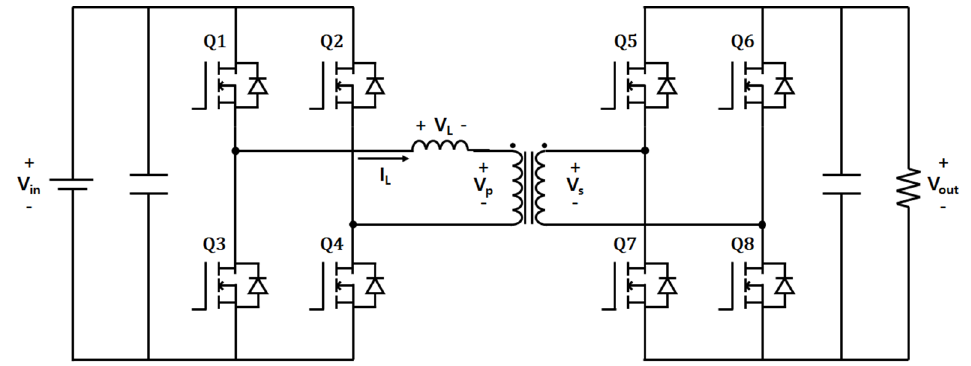
Figure 1. DAB converter circuit.